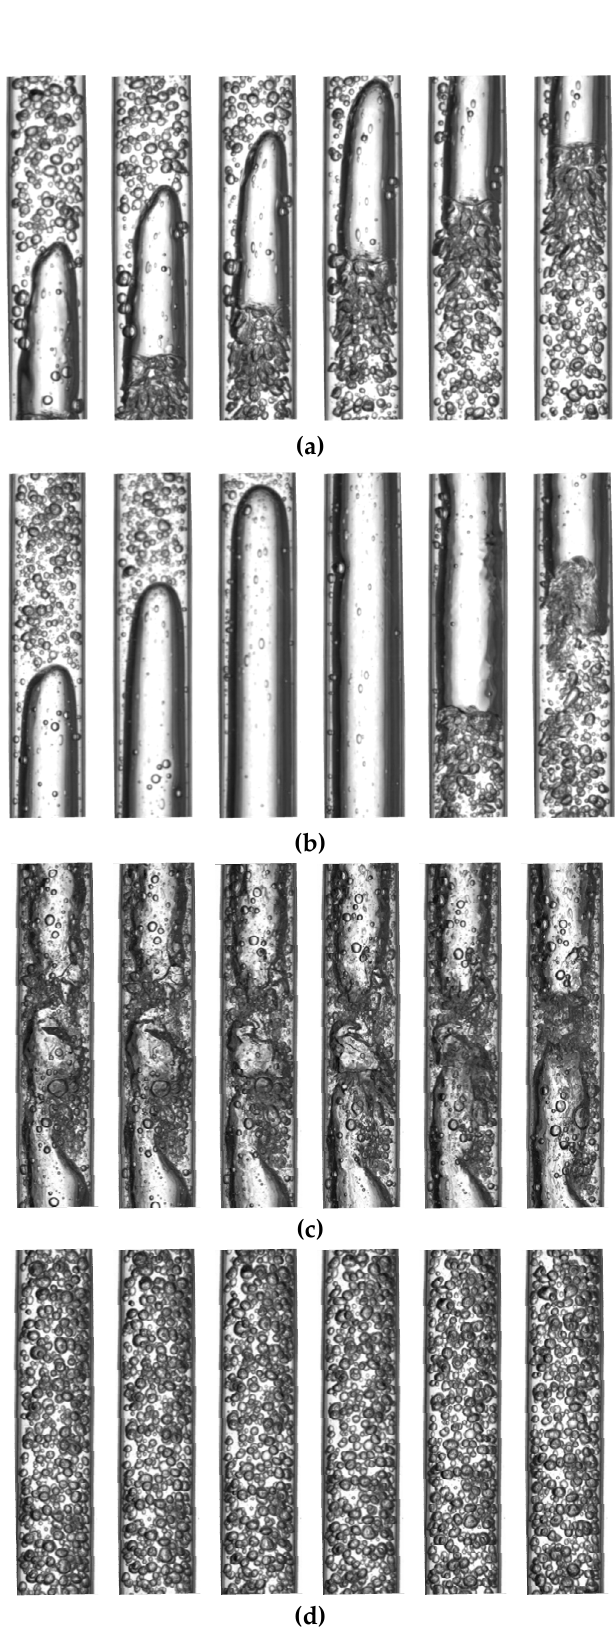
Figure 7. Snapshots of three typical flow patterns in gas–water two-phase flows (the interval of each frame is 0.01 s). ( a ) U sg = 0.055 m/s, U sw = 0.443 m/s, slug ( K w > 60%); ( b ) U sg = 0.368 m/s, U sw = 0.295 m/s, slug( K w < 60%); ( c ) U sg = 0.590 m/s, U sw = 1.105 m/s, churn; ( d ) U sg = 0.055 m/s, U sw = 0.884 m/s, bubble.